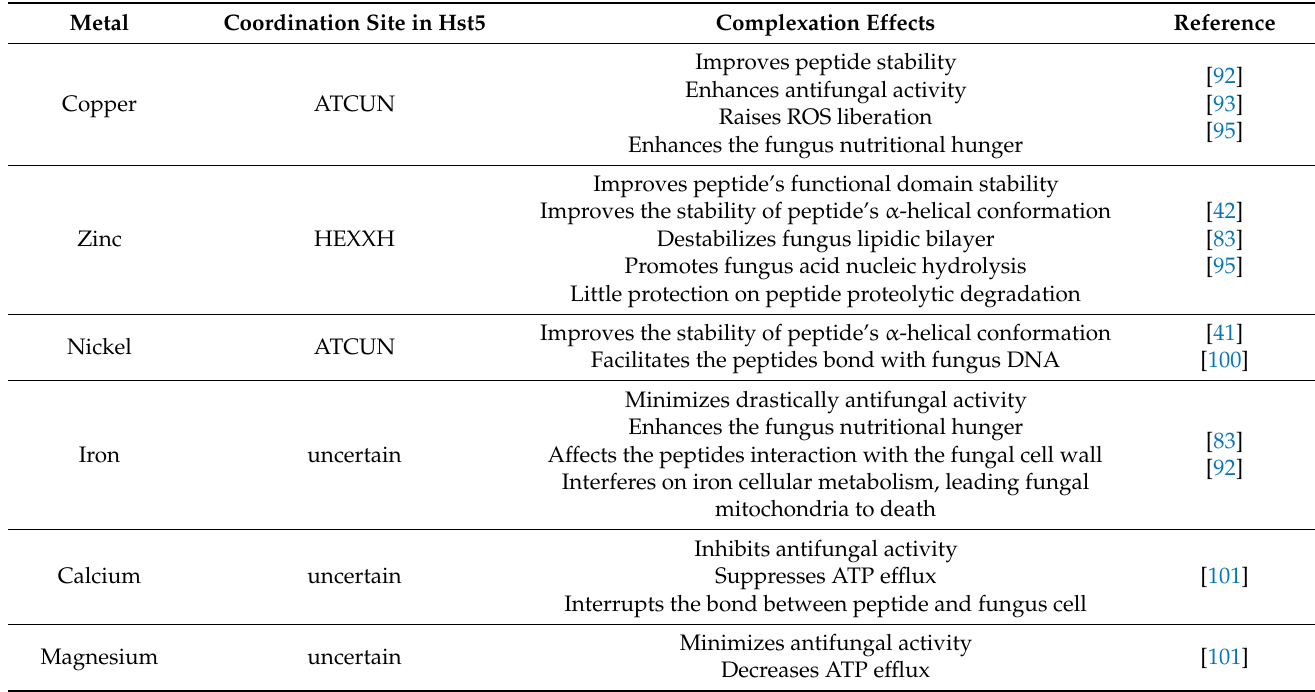
Table 1. Summary of the main findings of the effects on Histatin 5 by the metallic